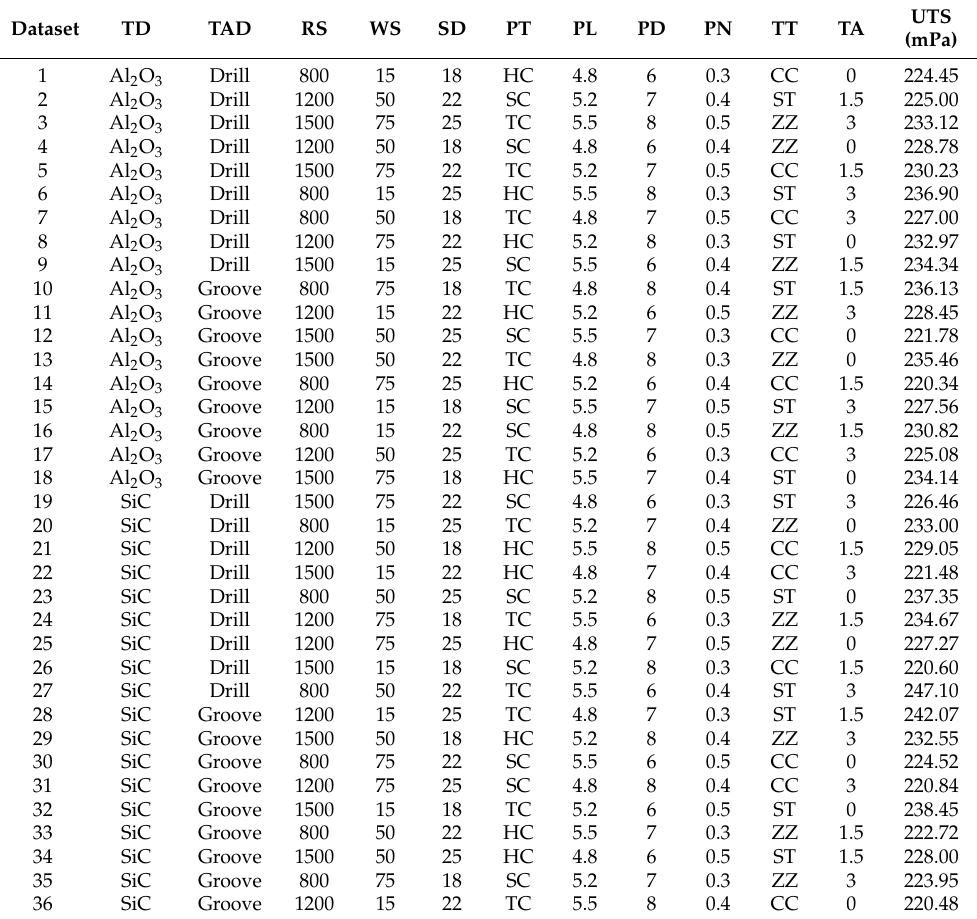
Table 14. Performance of different machine learning methods on the FSW-11PI-V2 dataset. Machine Learning and Ensemble Machine